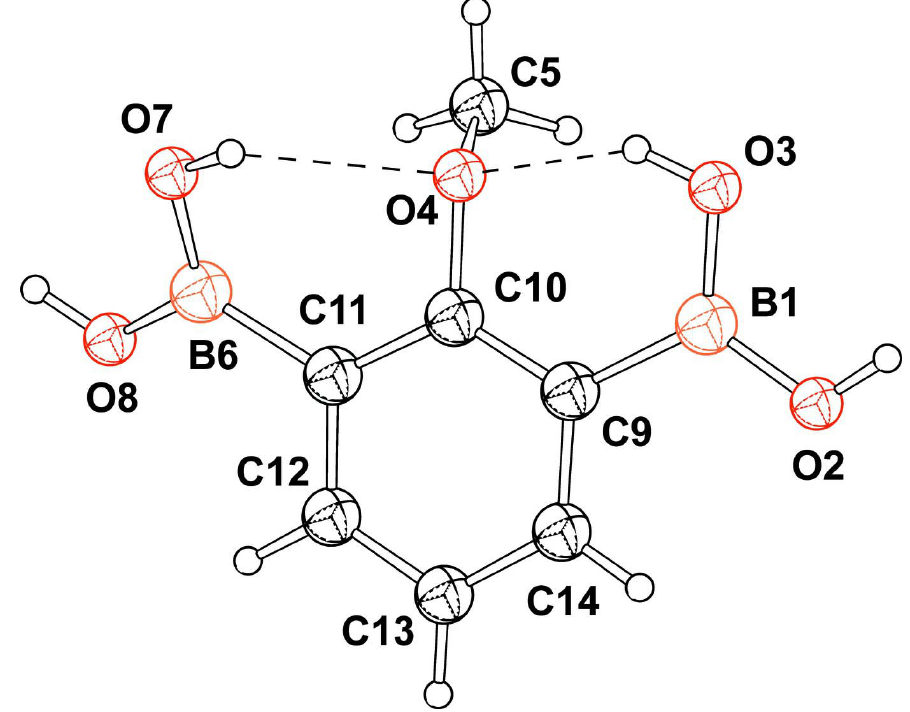
The molecular structure showing the atom-labelling scheme. Intramolecular hydrogen bonds are shown as dashed lines. Displacement ellipsoids for all non-H atoms are drawn at the 50% probability